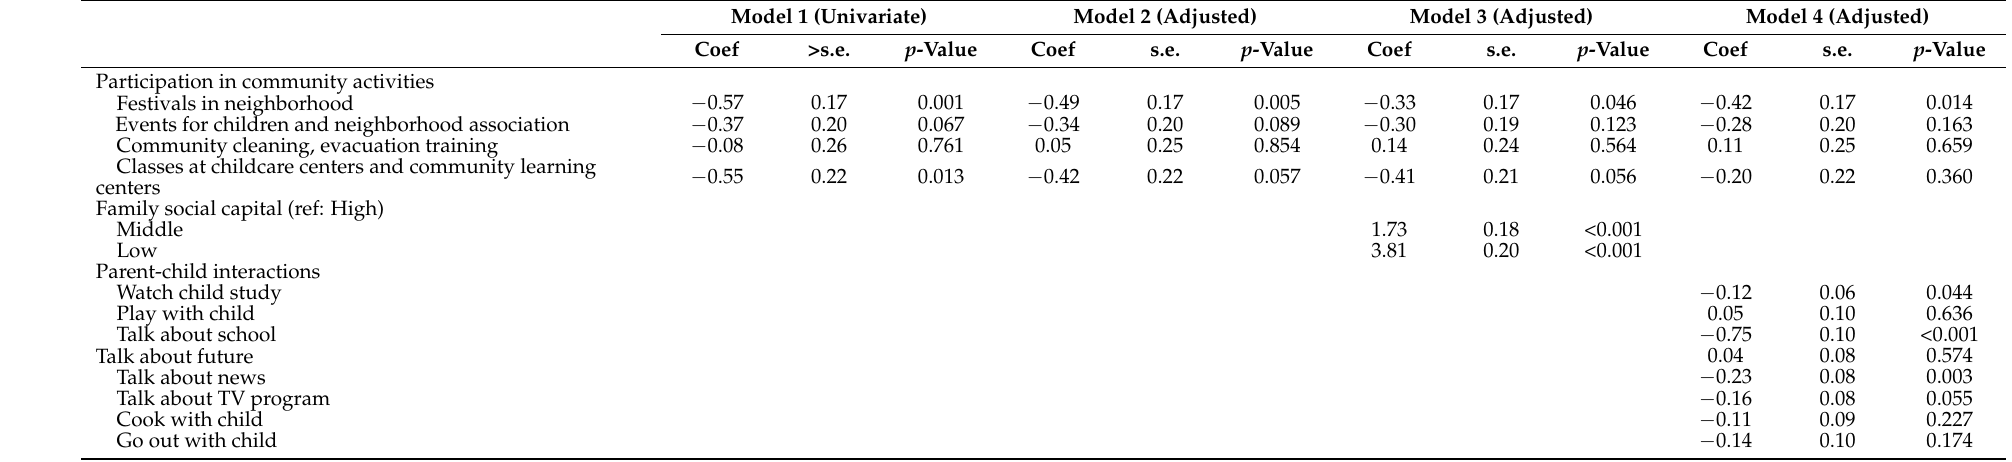
Table 3. Associations between participation in community activities and SDQ total score.